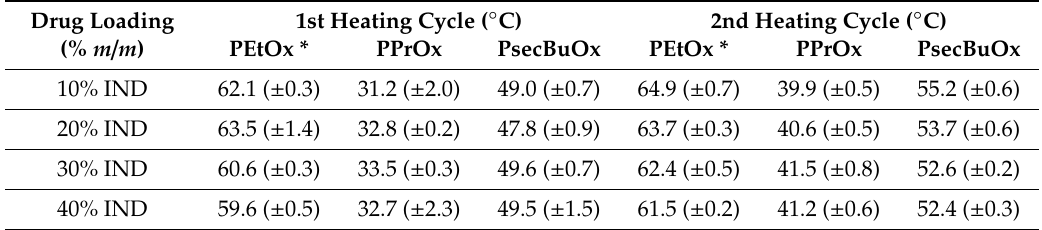
Table 3. Average T g s ( ± standard deviation) of binary ASDs with IND and PEtOx, PPrOx or PsecBuOx. mDSC measurements were performed in triplicate. Drug loading was increased from 10% to 40% IND.